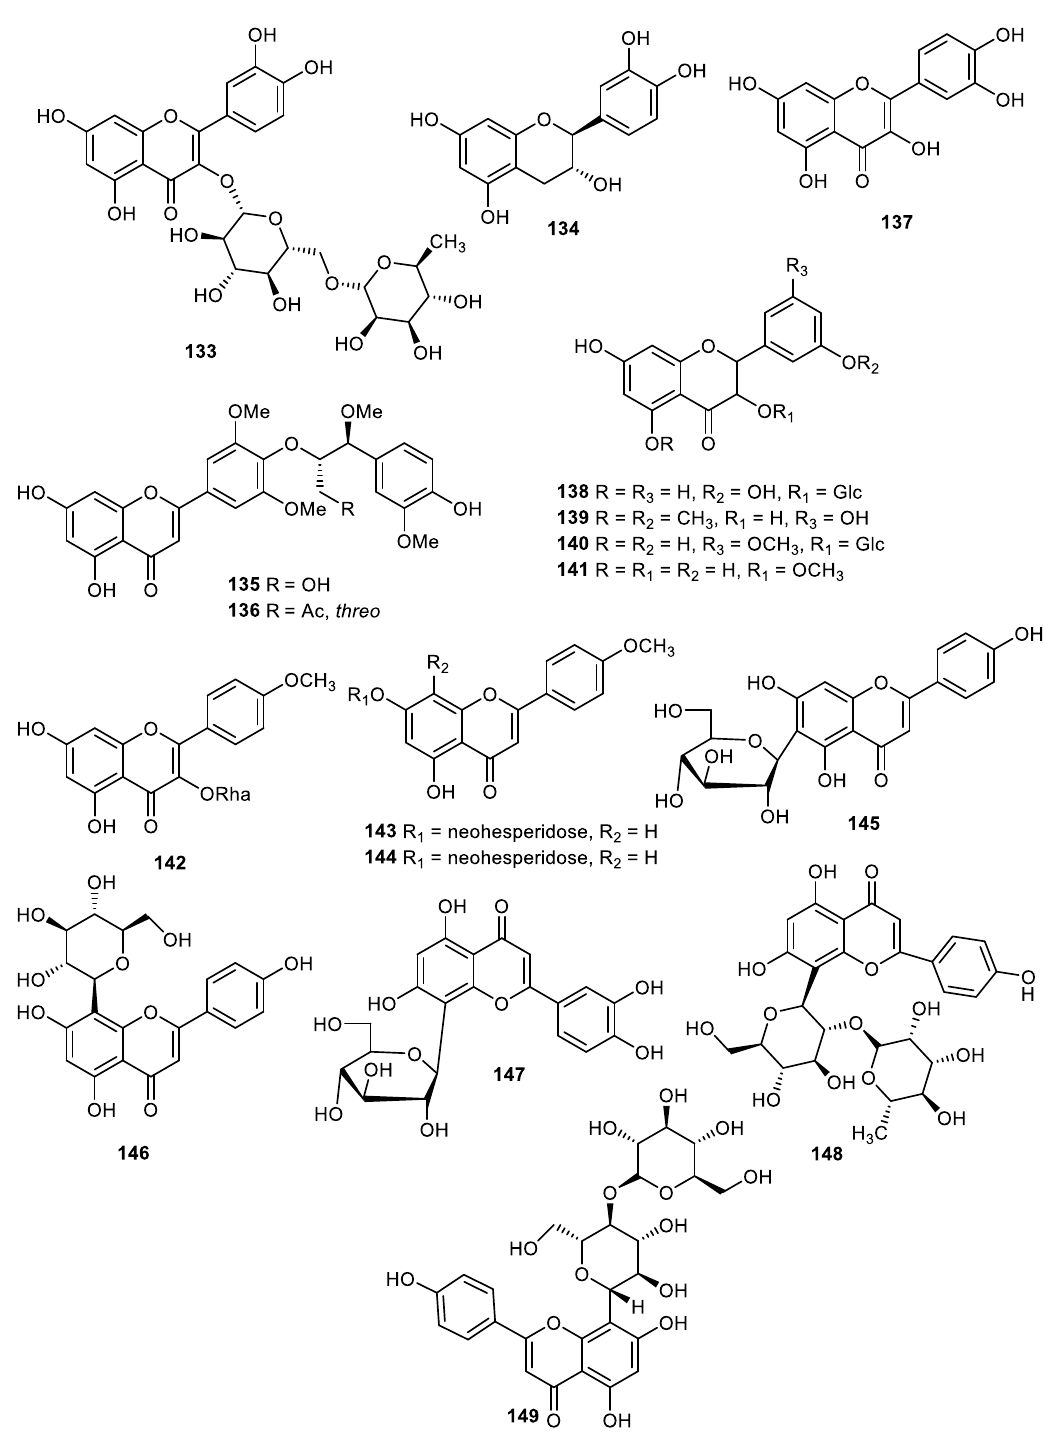
Figure 16. Structures of flavonoids 133 – 149 .